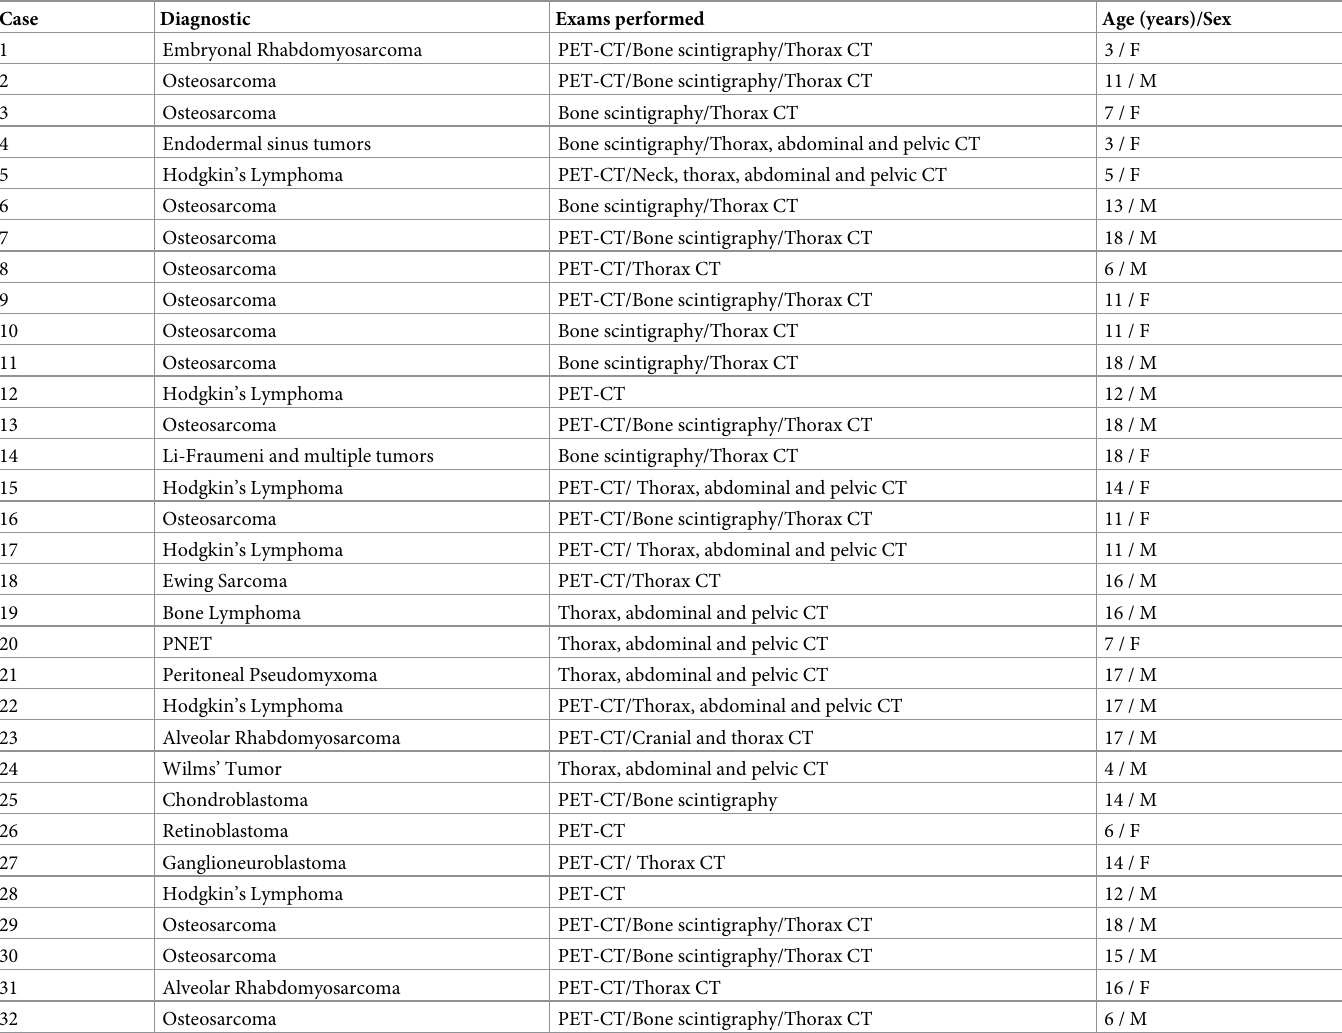
Table 2. The distribution of cases, diagnoses and exams performed in standard staging.